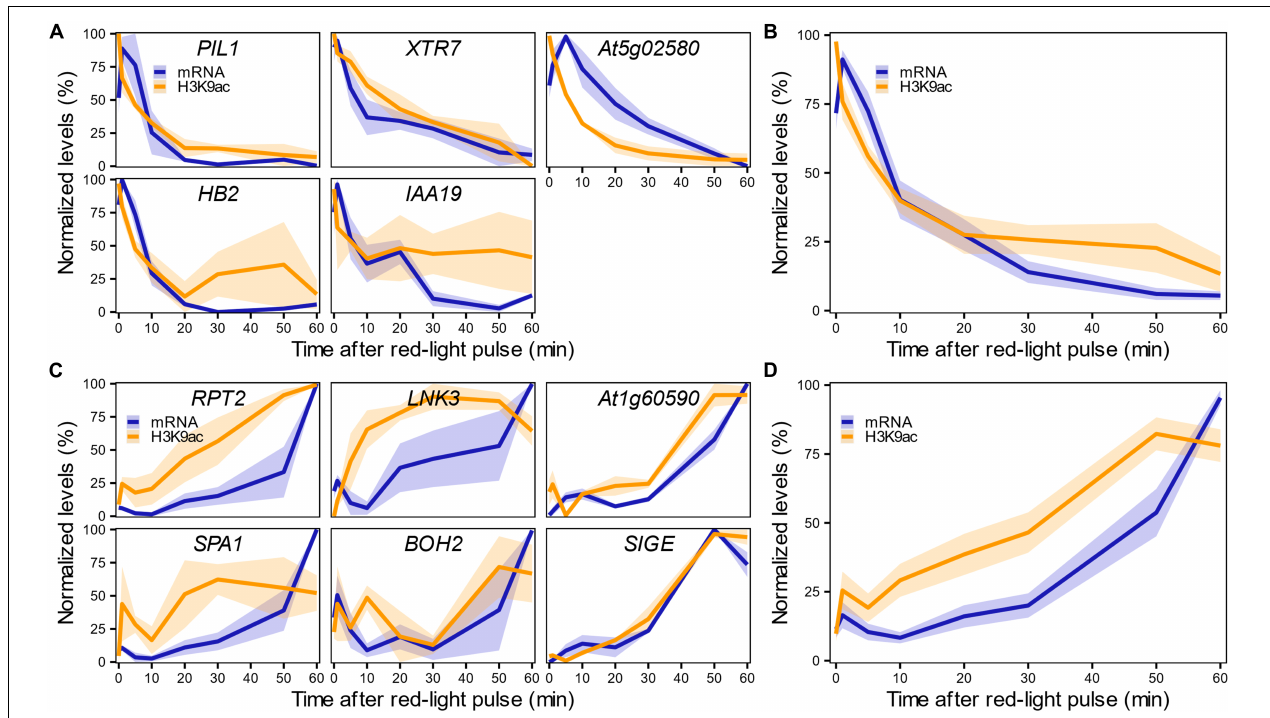
FIGURE 4 | H3K9ac changes in LRP-DTGs parallel the rapid transcriptional response in light-repressed LRP-DTGs, and apparently precede transcription in light-induced LRP-DTGs. H3K9ac and mRNA changes measured by ChIP-qPCR and RT-qPCR in light-repressed (A) and light-induced (C) LRP-DTGs after a saturating red-light pulse. Averaged mRNA and H3K9ac levels for each group of genes are shown in (B,D) , respectively. Data were re-scaled to the minimum and maximum mRNA/H3K9ac values for each gene. Each colored line represents the averaged mRNA/H3K9ac levels at each time point and the shaded band represents the standard error of the mean ( n =